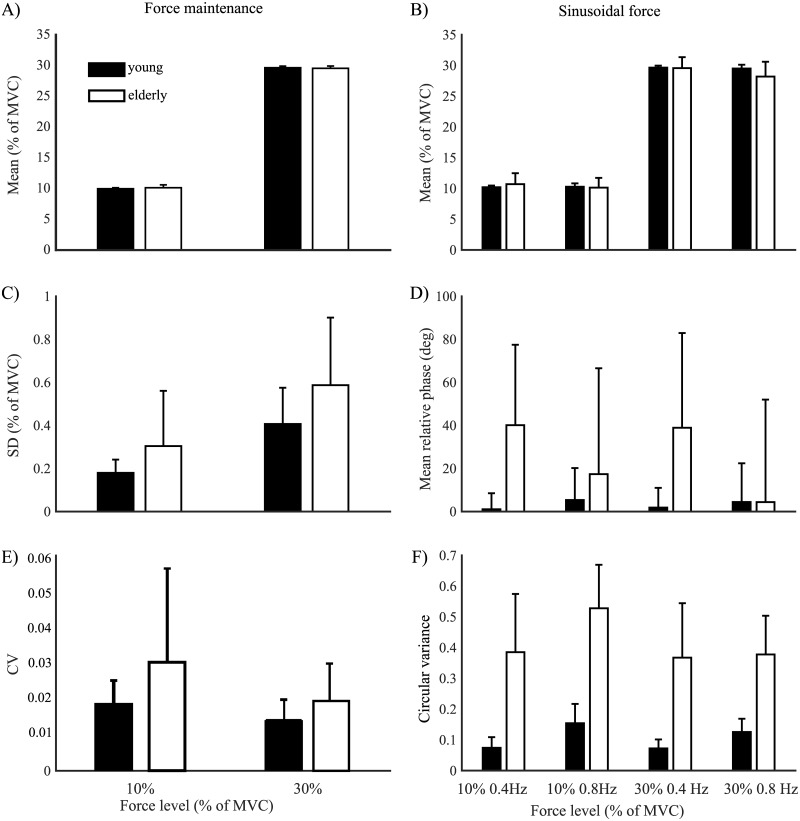
General characteristics of force production.(A) Mean force in the constant task and (B) the modulation task. (C) Standard deviation for the constant task. (D) Mean relative phase for the modulation task. (E) Coefficient of variation for the constant task. (F) Uniformity for the modulation task. Black bars represent the results of the young group, and white bars those of the elderly. Error bars represent the standard deviation.